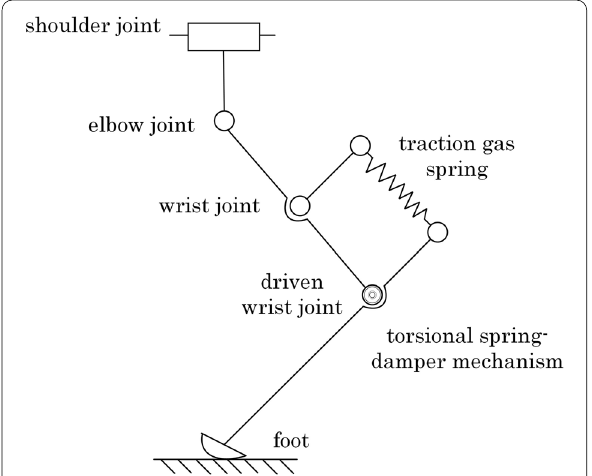
Figure 9 Structural sketch of the first-stage buffer